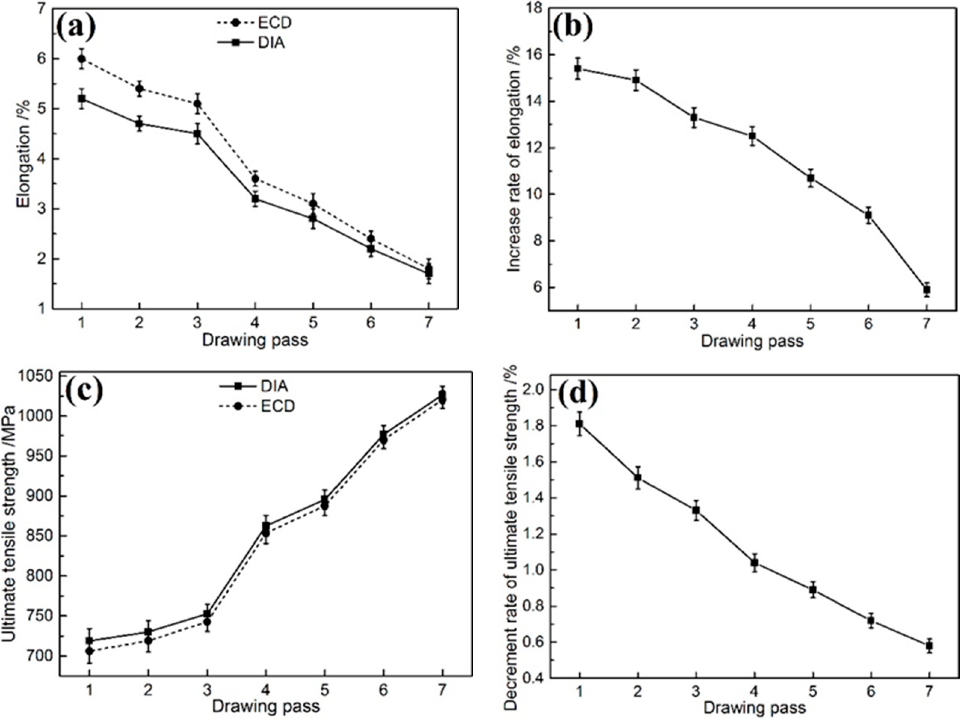
Figure 9. Variations in ( a ) elongations of ECD and DIA bars, ( b ) increment rate of elongation of ECD bar compared with DIA bar, ( c ) ultimate tensile strengths of ECD and DIA bars, and ( d ) decrement rate of ultimate tensile strength of ECD bar compared with DIA bar with drawing pass.